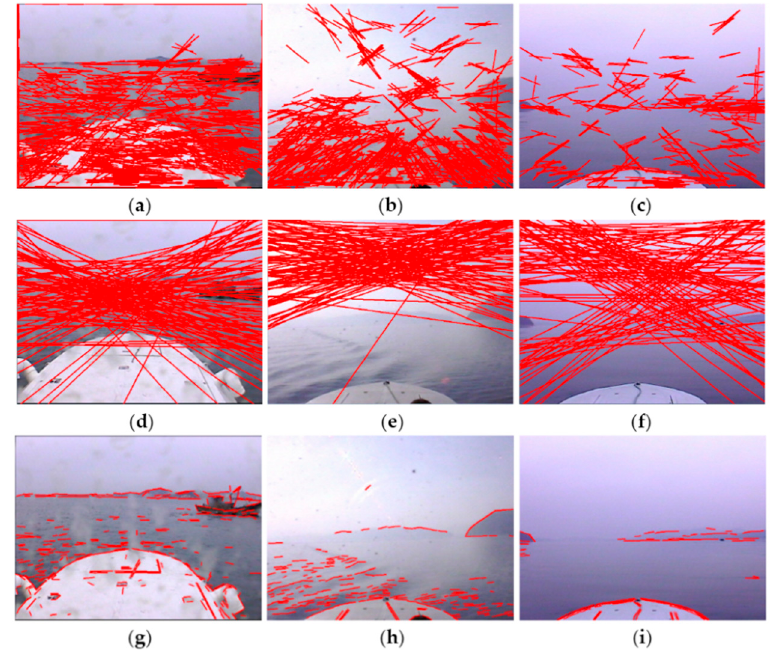
Figure 11. Line feature detection results of optical images: ( a – c ) are results of the Hough transform method; ( d – f ) are results of Radon transform method; ( g – i ) are results of the proposed method.